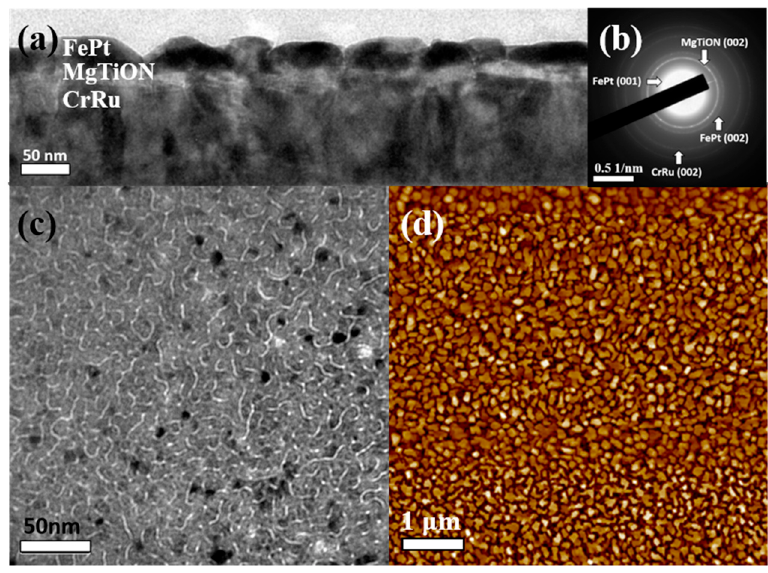
Figure 5 . ( a ) cross-sectional TEM images; ( b ) SAD of (a); ( c ) plan-view; TEM images and ( d ) surface roughness of reference sample, FePt(14 nm)/MgTiON/CrRu film.